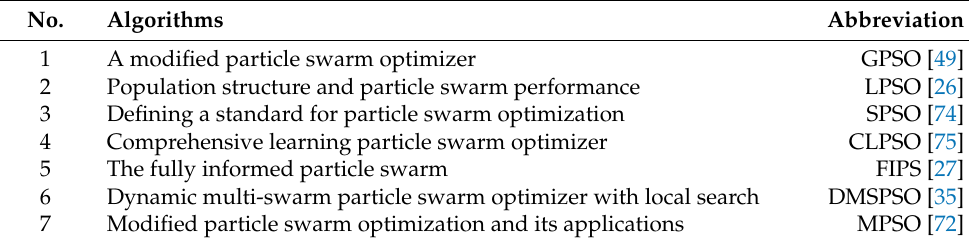
Table 5. The popular algorithms used for